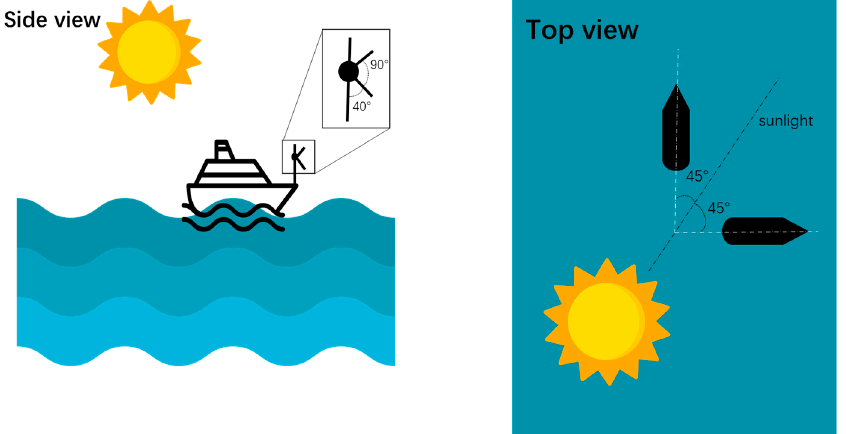
Figure A1. Conceptual view of the unmanned ship carrying a micro-spectrometer to collect water body spectrum; the side view details the angle of measurement of the zenith angle of the three sensors followed for spectrum collection and the top view details the angle of measurement of the azimuth of the three sensors for spectrum collection.